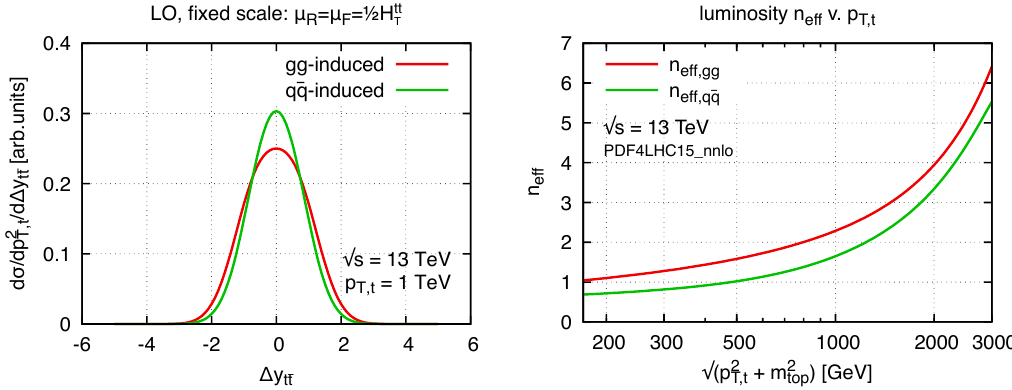
distribution at fixed large p , as T,t t ¯ t √ + m 2 . / 2 = p 2 top T T,t